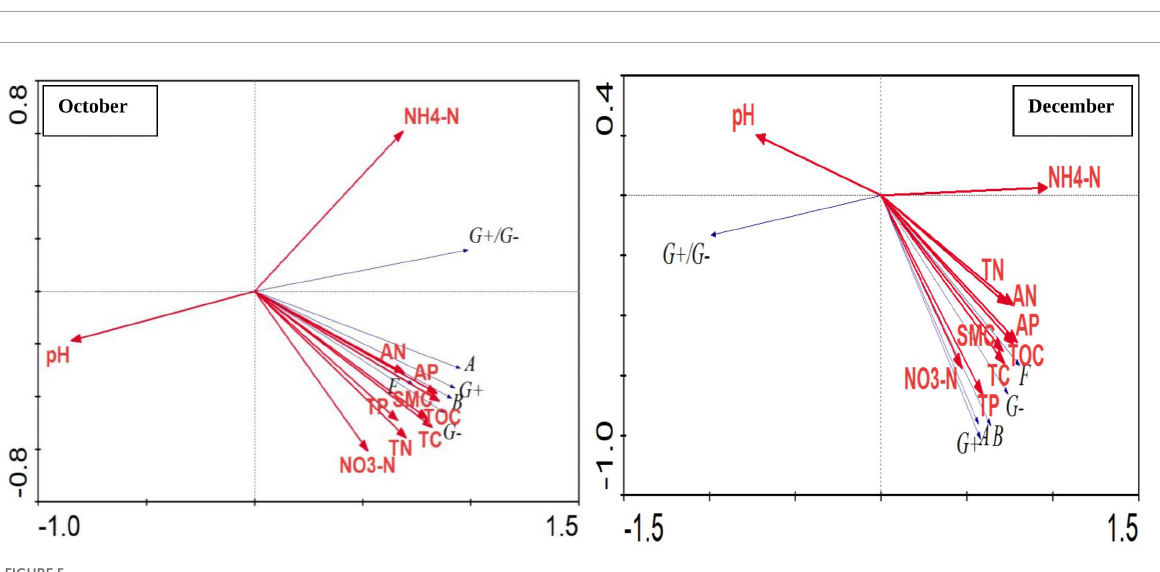
with soil pH at p ≤ 0.05 level of significance. Flavobacteriia population was positively correlated with TOC, TC, TN, AP (at p ≤ 0.01), WC, NO 3 N, TP and Shannon index (at p ≤ 0.05) while negatively correlated